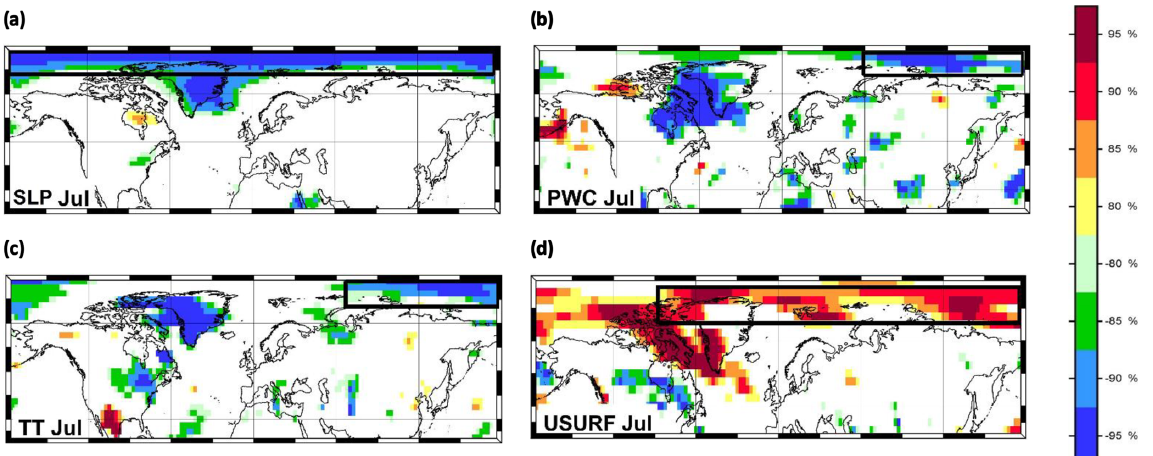
Figure 3. Stability map of the correlation between September sea ice extent and (a) SLP Jul, (b) PWC Jul, (c) TT Jul and (d) USURF Jul. Regions where the correlation is stable, positive and significant for at least 80% of the 21-year windows are shaded with dark red (95%), red (90%), orange (85%) and yellow (80%). The corresponding regions where the correlation is stable, but negative, are shaded with dark blue (95%), blue (90%), green (85%) and light green (80%). The black boxes indicate the regions used for the September sea ice extent at the end of July in addition to the variables of May and